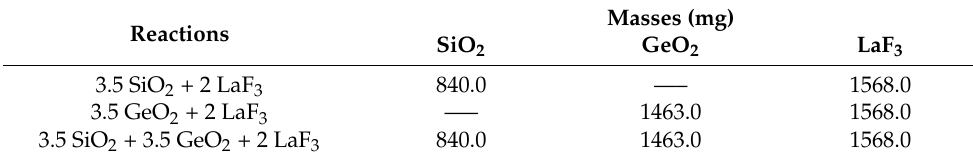
Table 2. Starting amounts of each compound in each